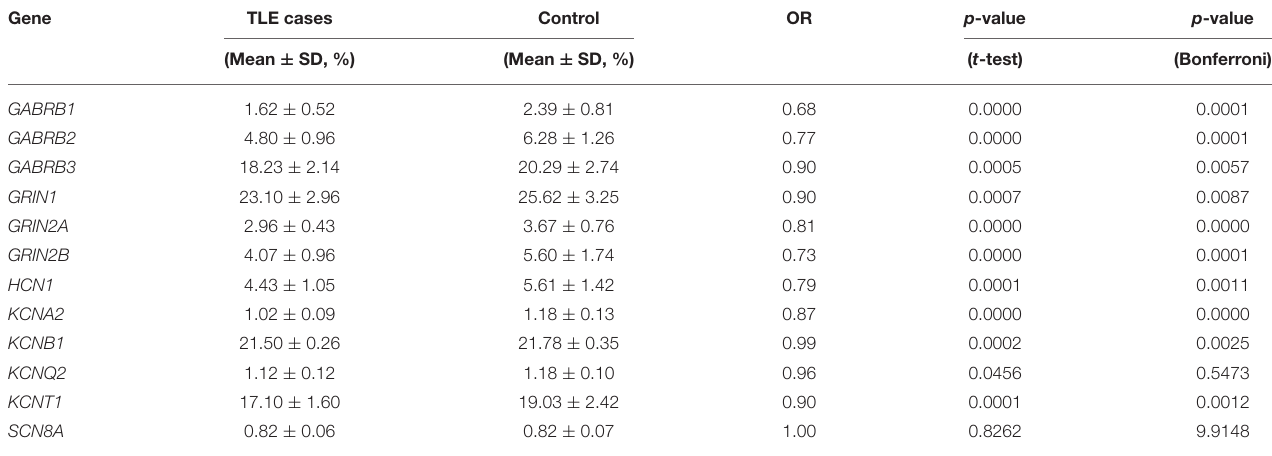
TABLE 2 | DNA methylation status of 12 ion-channel genes between TLE cases and controls.